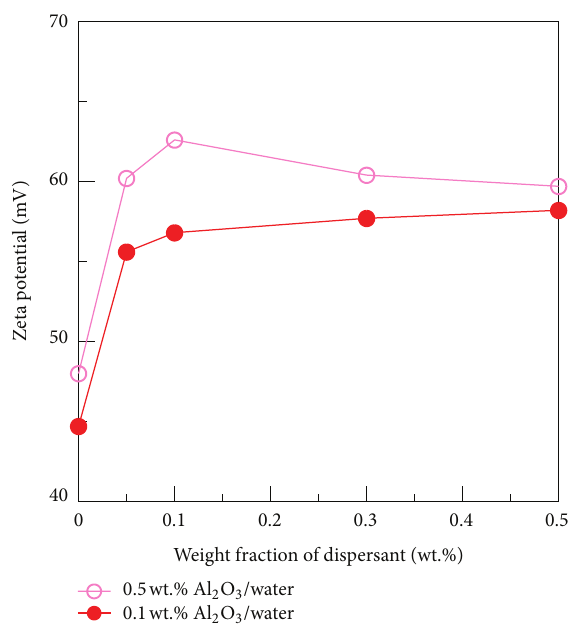
Figure 2: Correlation between zeta potential and weight fraction of dispersant.